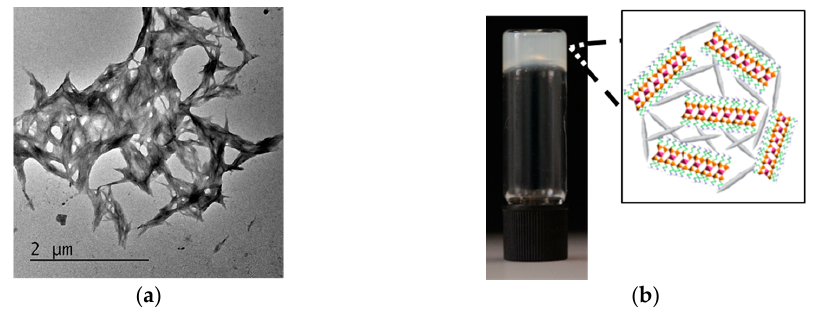
Figure 1. ( a ) Unstained TEM image of cellulose nanocrystal (CNC)-organoclay hydrogel; ( b ) photograph showing self-supported CNC:organoclay (1:0.13) colloidal nanocomposite hydrogel, inset showing schematic illustration of cross-linked network formed by non-covalent interactions between CNC (grey) and exfoliated organoclay